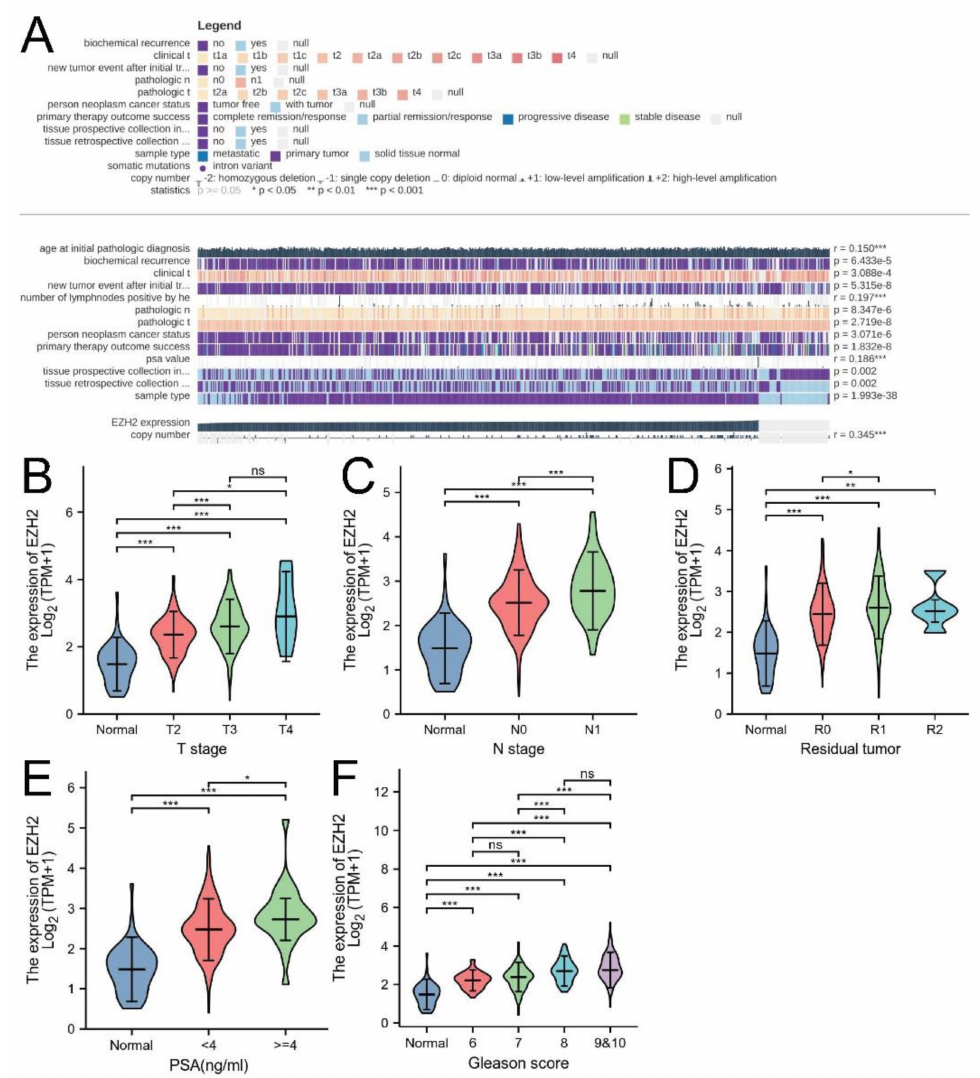
Figure 3. Associations between EZH2 expression and clinicopathologic parameters. ( A ) Associations between EZH2 expression and clinicopathologic parameters using MEXPRESS. Violin plots indicating EZH2 expression in different ( B ) T stage, ( C ) N stage, ( D ) residual tumor, ( E ) PSA, and ( F ) Gleason score from the TCGA database. No significance, p -values < 0.05, 0.01, and 0.001 were presented as “ns”, “*”, “**”, and “***”,